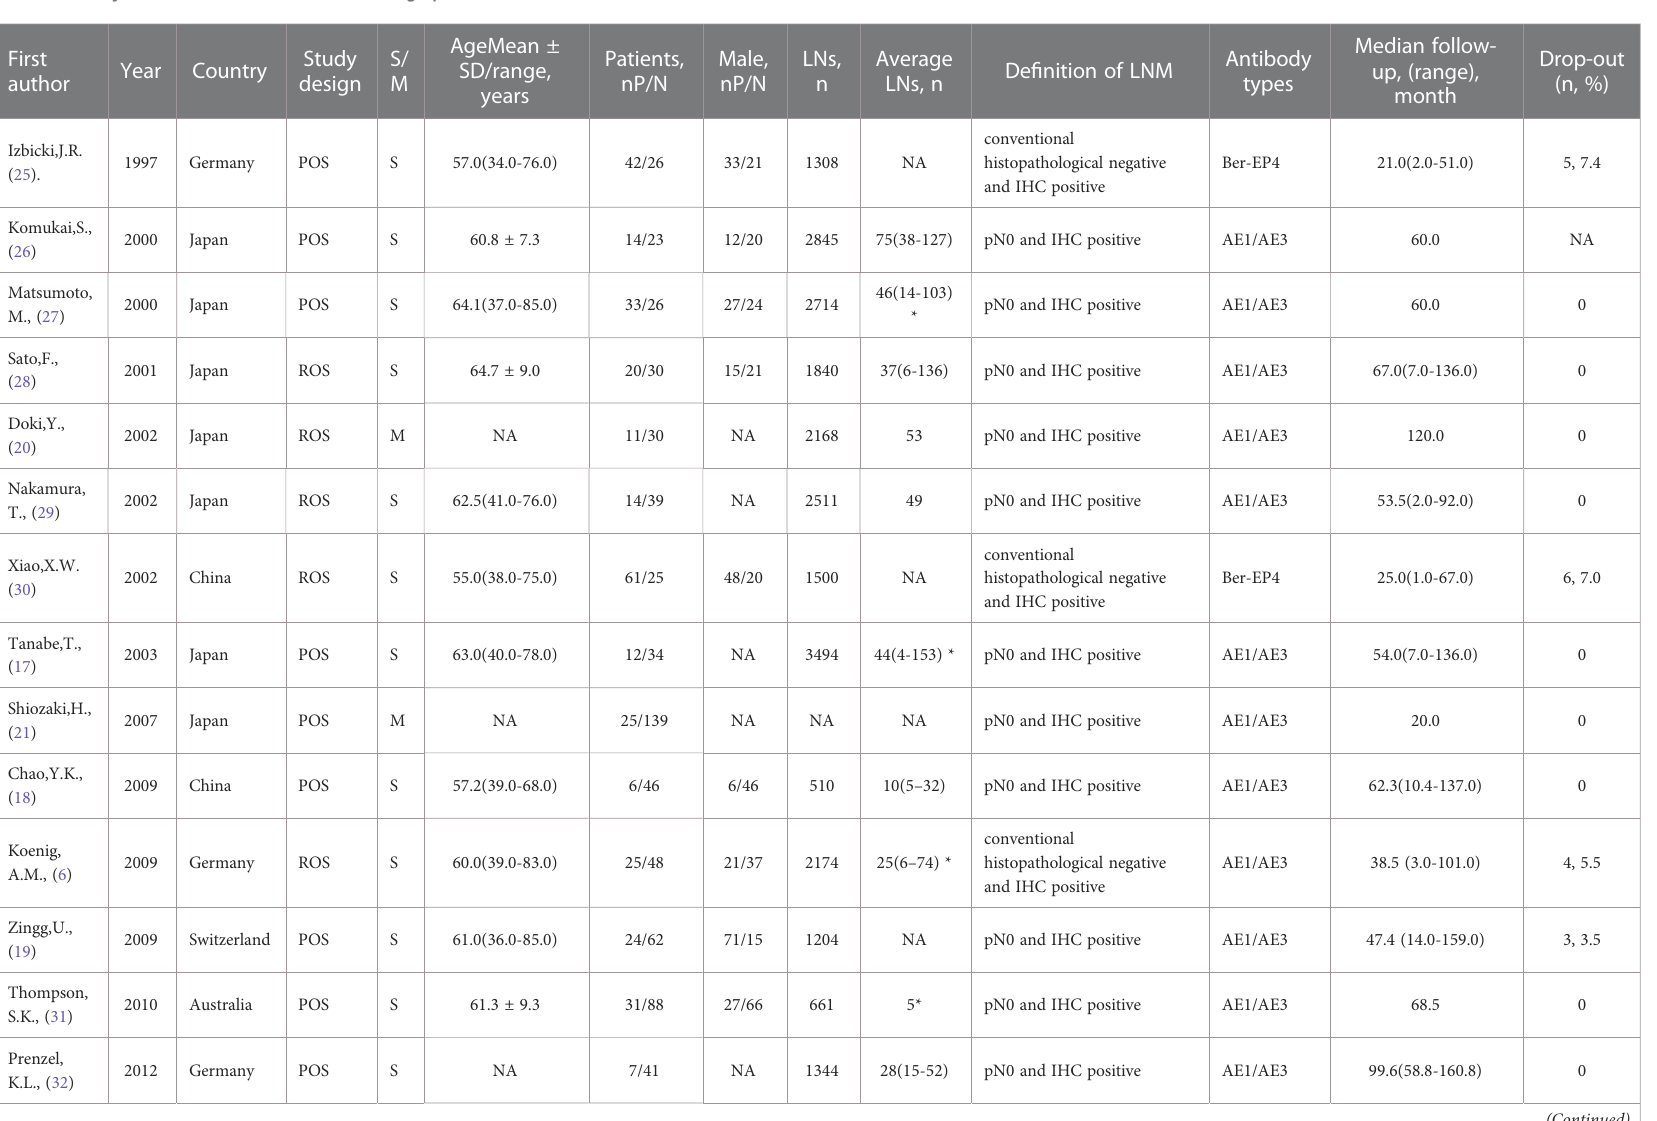
TABLE 1 Study characteristics and baseline